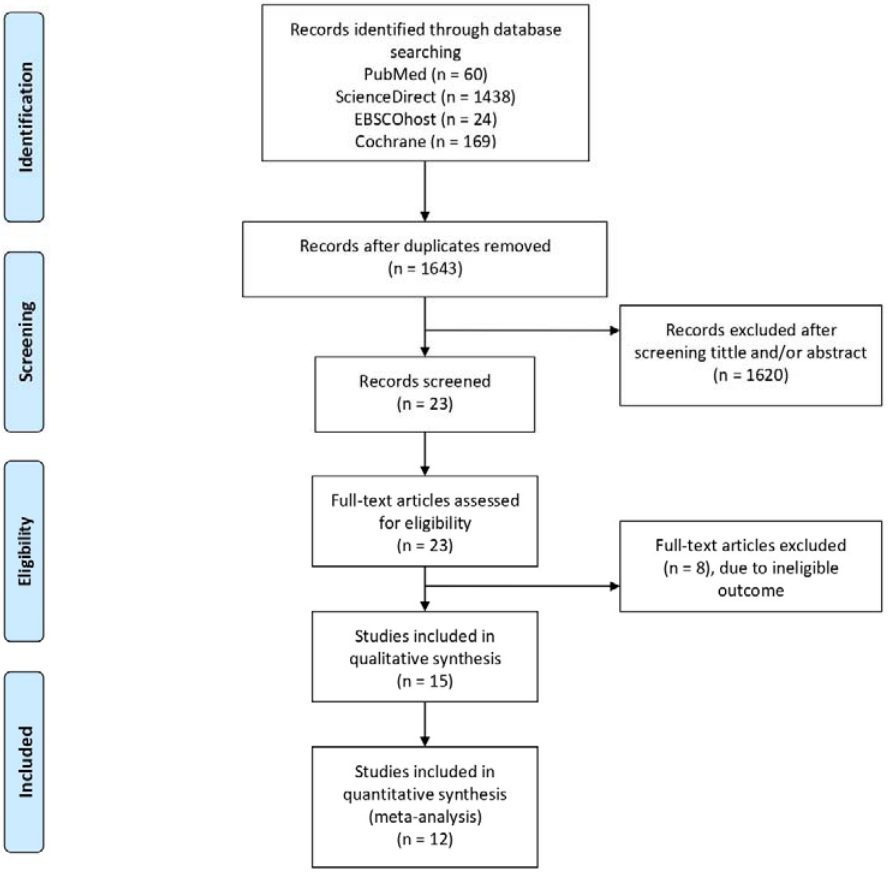
Figure 1. PRISMA flow diagram.